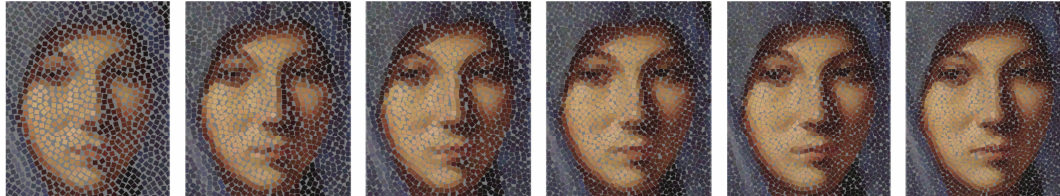
Figure 8: Examples of mosaics obtained by using only subtractive cut with 𝑇 𝑁 ranging from 0% (no cut) to 50% (step of 10%) and the ratio between single and total cut 𝑅 𝑁 fixed to 1 = 2 .